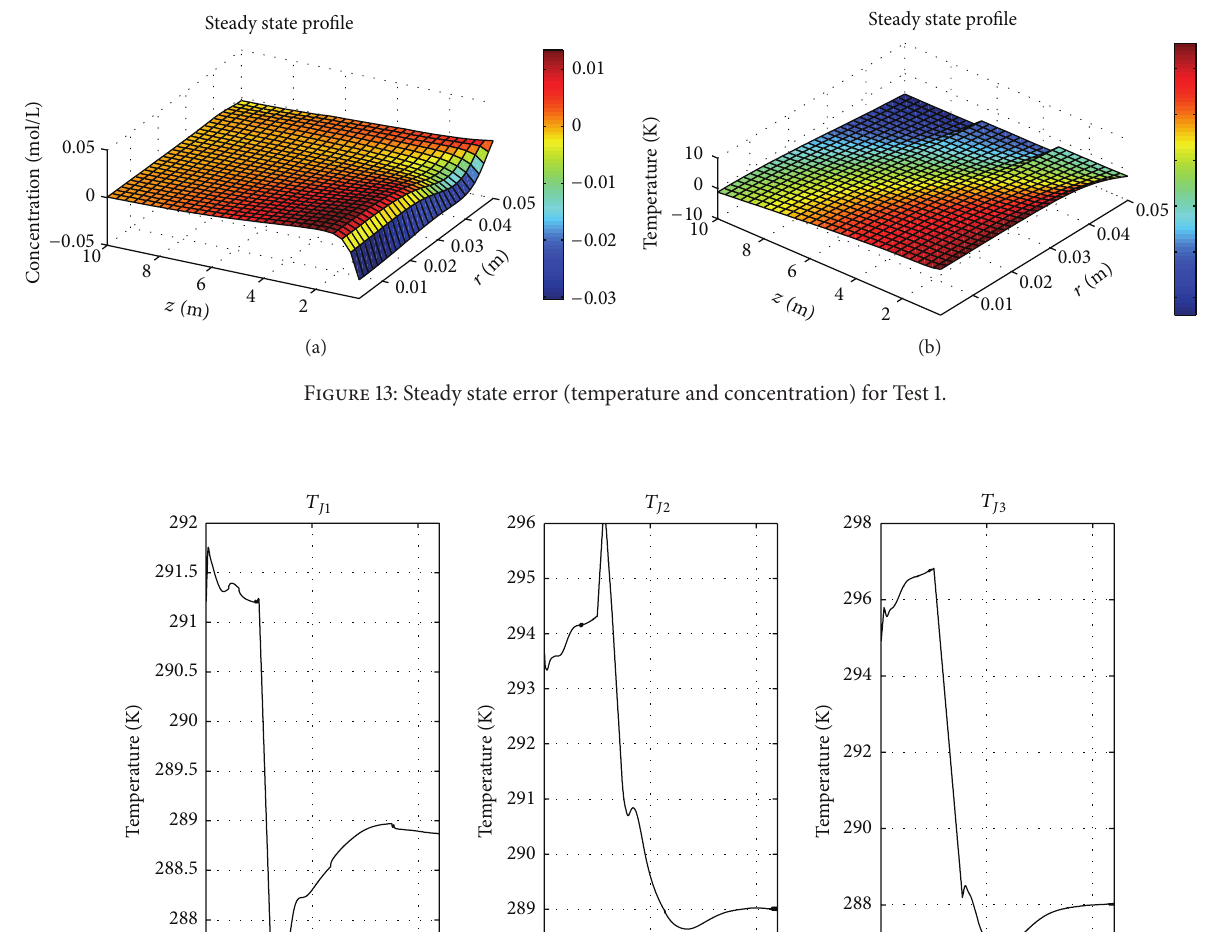
Profiles at 𝑧 = 10 m